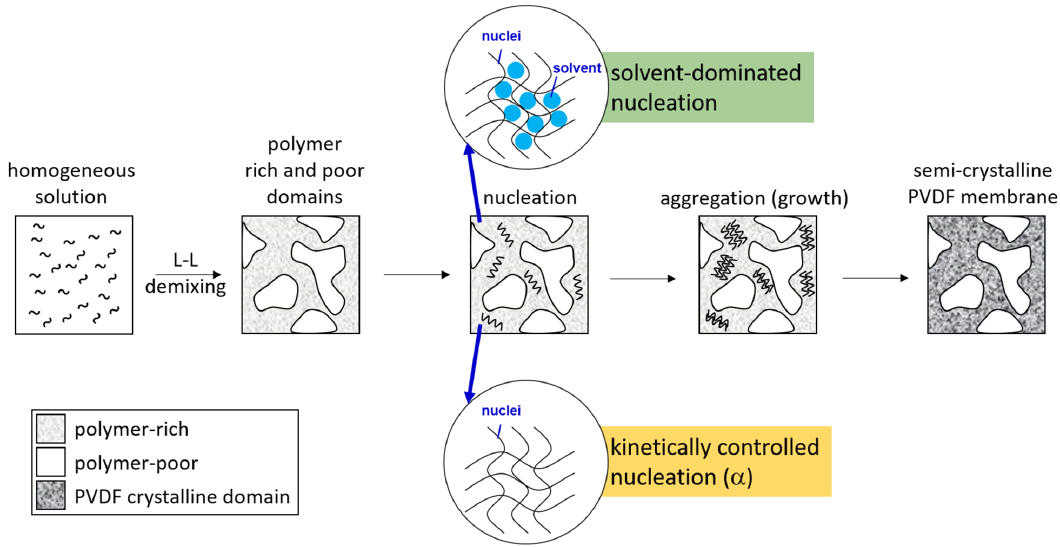
Figure 7. Schematic presentation of the formation mechanism of PVDF